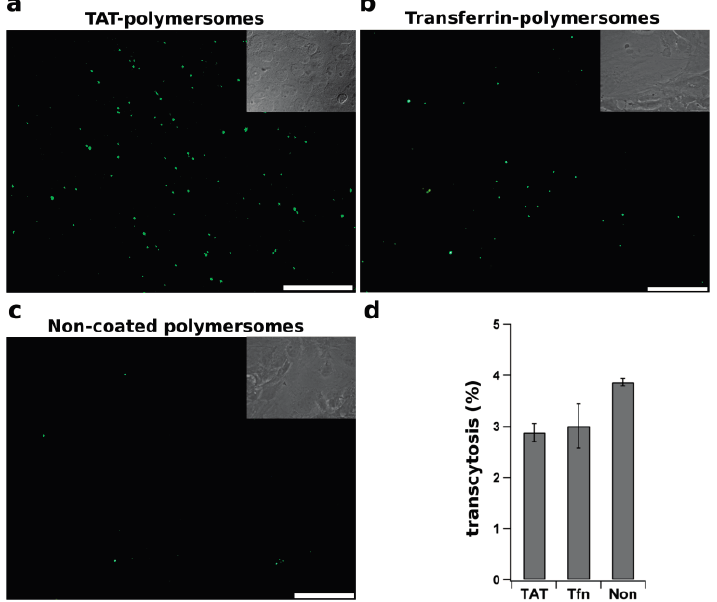
Figure 3. Internalization and transcytosis of functionalized polymeric nanoparticles. TAT peptide and transferrin were covalently attached to polymersomes and incubated for 18 h at 37 °C with polarized filter-grown endothelial hCMEC/D3 cells, a convenient in vitro model for the BBB (see [132]). After extensive washing to remove non-bound particles, the cells were examined by fluorescence microscopy to visualize the intracellular distribution of ( a ) TAT-, Transferrin (Tf)- and non-coated polymersomes, as indicated (Scale bar: 20 µm); Alternatively ( b ), after 18 h of incubation at 37 °C the fractions of polymersomes in the apical and basolateral medium were measured and the fraction of polymersomes, transported by transcytosis across the endothelial cells, was